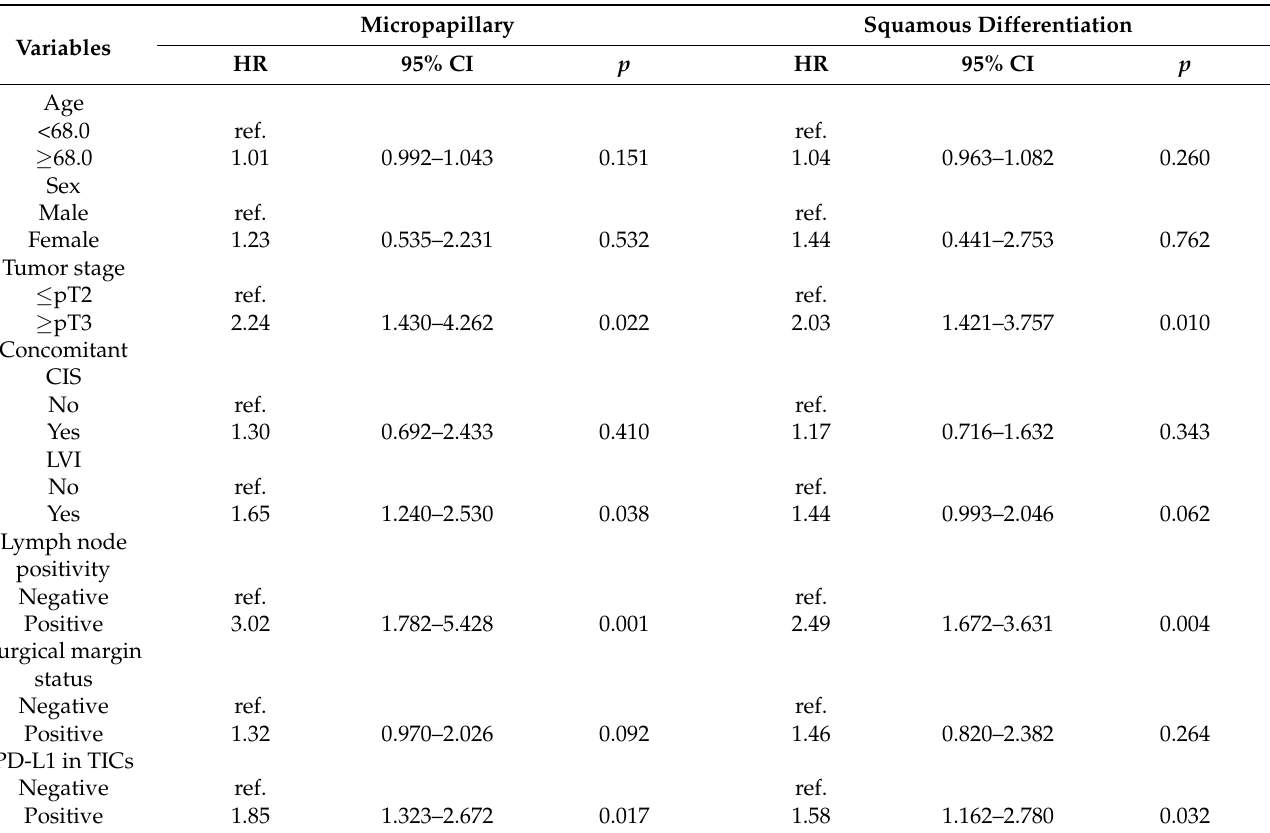
Table 3. Multivariable Cox proportional hazard regression analyses to predict tumor